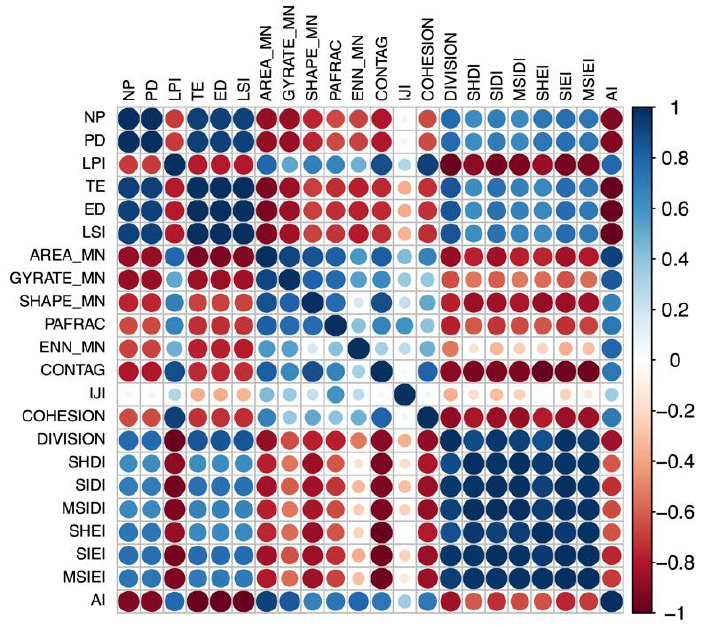
Figure 2. Correlation matrix for landscape metrics, using the landscape level as an example.